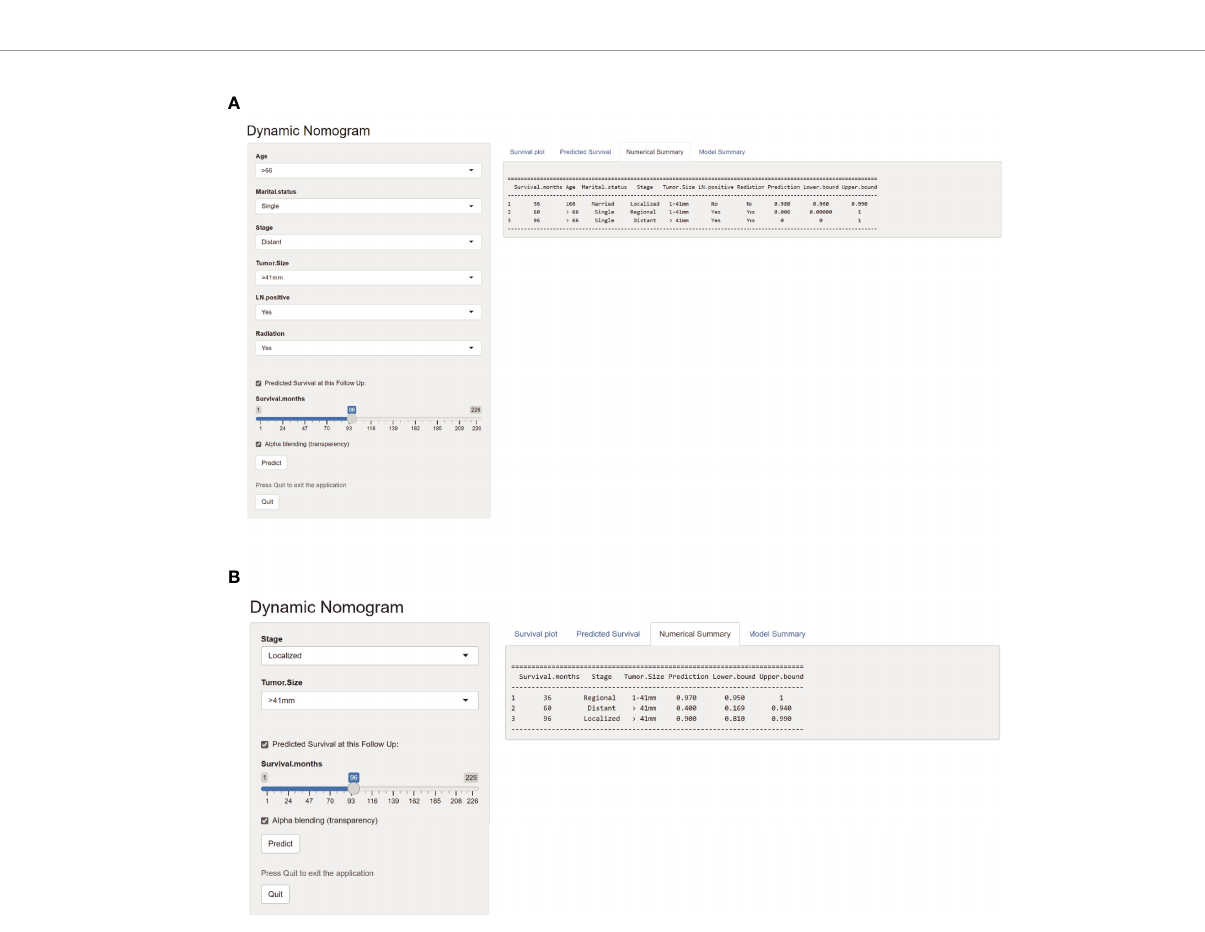
FIGURE 9 | Web-based probability calculators. The 3-, 5-, and 8-year overall survival rate probability was calculated (A) . The 3-, 5-, and 8-year cancer-speci fi c survival rate probability was calculated (B)